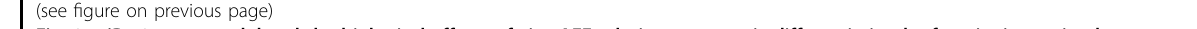
Fig. 3 miR-135a-5p modulated the biological effects of circ_AFF4 during osteogenic differentiation by functioning as its downstream target gene. A Potential targeted binding between miR-135a-5p and AFF4 was predicted by using TargetScan and Starbase web tools. The identi fi ed complementary binding sites were further validated by performing dual-luciferase reporter ( B ) and RNA pull-down assays ( C ). D BM-MSCs were transfected with lentiviruses encoding circ_AFF4 or empty viruses, si-circ_AFF4 or si-NC. Relative expression of miR-135a-5p and circ_AFF4 was detected by qRT-PCR. E BM-MSCs were co-transfected with lentiviruses encoding circ_AFF4 and miR-135a-5p mimics or miRNA negative control. The relative expression of miR-135a-5p was measured by qRT-PCR. F BM-MSCs were co-transfected with lentiviruses encoding circ_AFF4 and miR-135a-5p mimics or miRNA negative control, and further cultured in OM or NM for 14 days. ARS and ALP staining were performed to evaluate the osteogenic differentiation in BM-MSCs. G BM-MSCs were co-transfected with lentiviruses encoding circ_AFF4 and miR-135a-5p mimics or miRNA negative control, and further cultured in OM for 14 days. RUNX2 expression was analyzed by immuno fl uorescence staining using RUNX2-speci fi c antibodies. H Fourteen days after osteogenic differentiation induction, the qRT-PCR assay was performed to determine the mRNA expression of osteogenic marker genes ALP, BMP4, RUNX2, Spp1, and Colla1 in BM-MSCs. I Protein expression levels of the osteogenic marker genes above was determined using western blot. The data were shown as mean ± SD based on at least three independent experiments. * P < 0.05, ** P < 0.01, and *** P < 0.001.